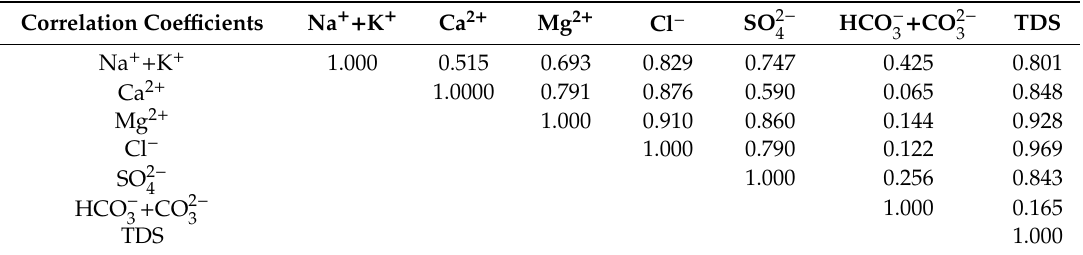
Table 4. Correlation coefficients between major groundwater ions and TDS (number of sampling points: 153).